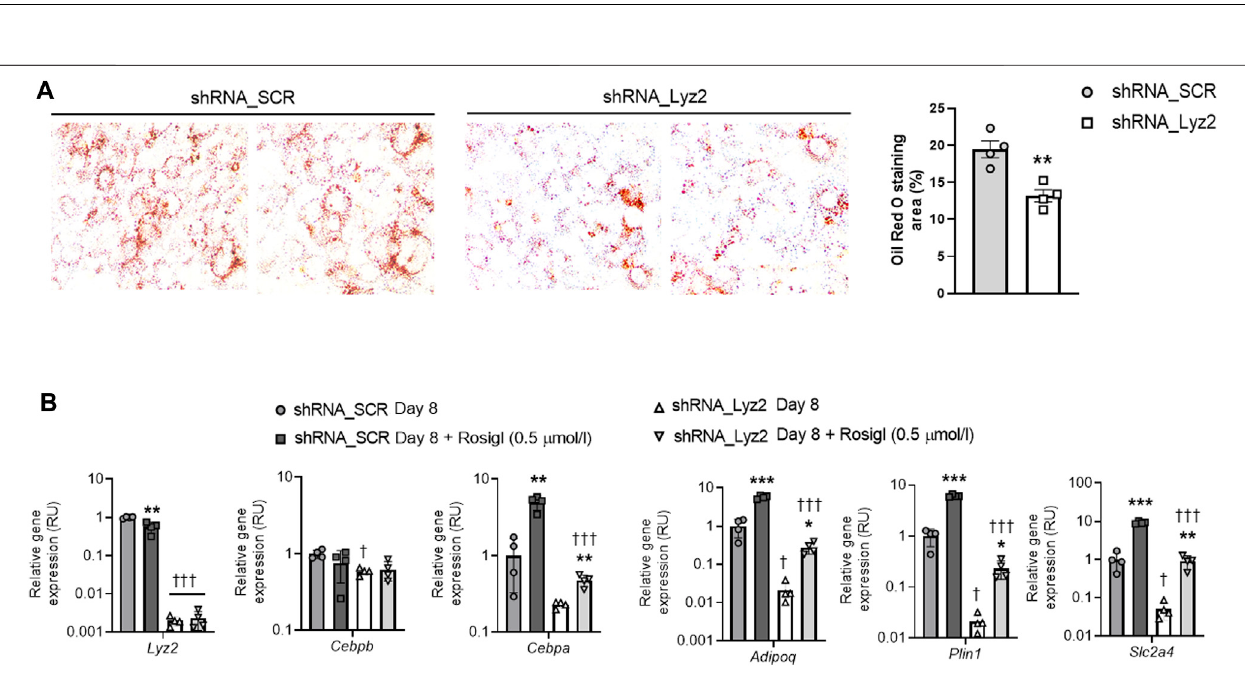
FIGURE 3 | (A) The impact of Lyz2 gene knockdown on intracellular lipid accumulation, which was measured as Oil Red O staining area (%), at day 8 of adipocyte differentiation. The lens magni fi cation used was ×10. ** p < 0.01 compared to shRNA_SCR. (B) The impact of rosiglitazone (0.5 μ mol/L) administration during adipocyte differentiationon Lyz2,Cebpb,Cebpa, Adipoq,Plin1 and Slc2a4 geneexpression atday8inshRNA_SCRandshRNA_Lyz2cells.* p < 0.05,** p < 0.01and*** p < 0.001 compared to vehicle; † p < 0.05 and ††† p < 0.001 compared to shRNA_SCR.